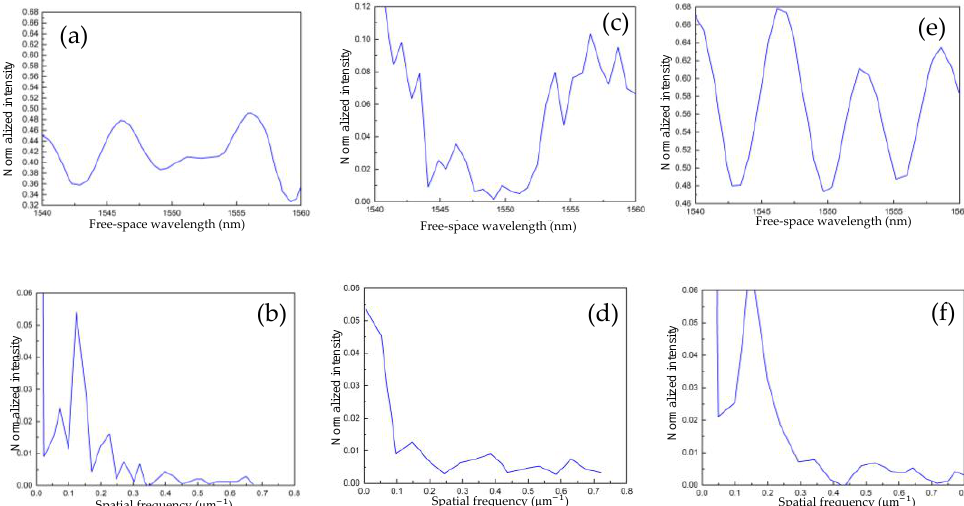
Figure 2. ( a ) Simulation results of transmission interference spectrum and its ( b ) Fourier transformed spectrum of STS M-Z interferometer. ( c ) One air cavity (W = 100 µ m and D = 8.4 µ m) M-Z interferometer simulation transmission and its ( d ) Fourier transformed spectrum. ( e ) One air cavity (W = 20 µ m and D = 80 µ m) M-Z interferometer simulation transmission and its ( f ) Fourier transformed